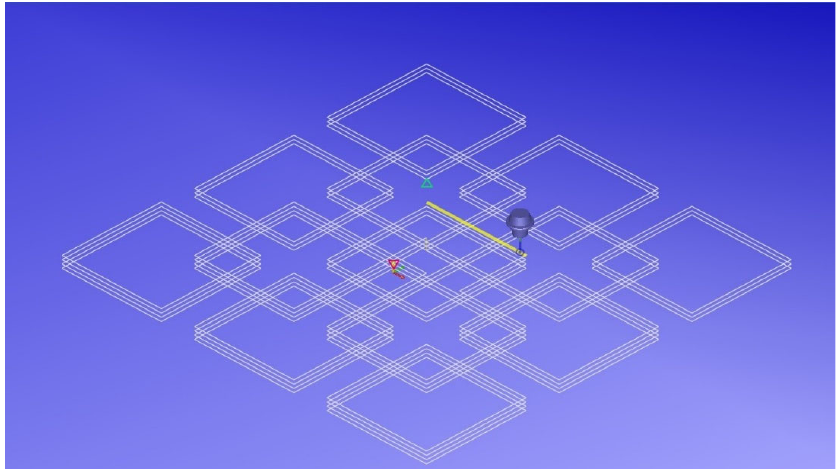
Figure 7. CIMCO Edit 8 interface running a simulated printing experiment.